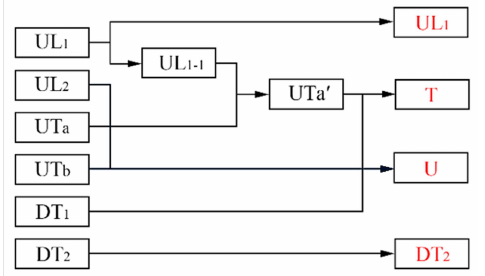
Figure 26. The schematic diagram of vortex evolution in UL-T-U-DT